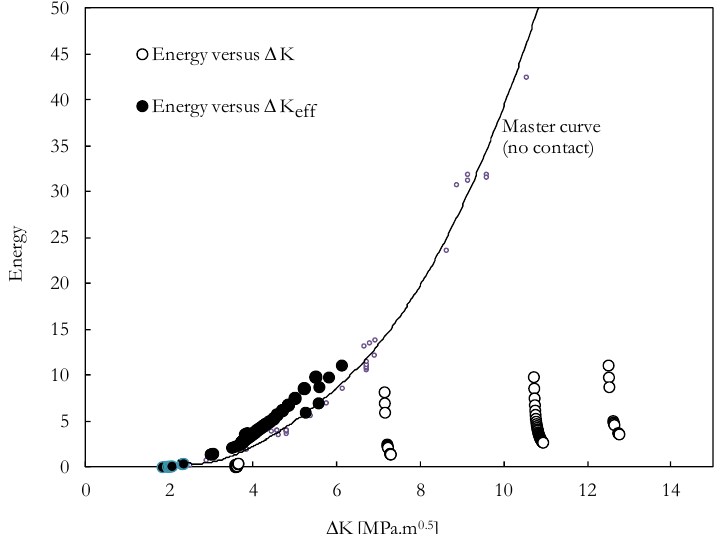
Figure 6: Effect of effective stress intensity factor range,  K eff , on dissipated energy after overloads.